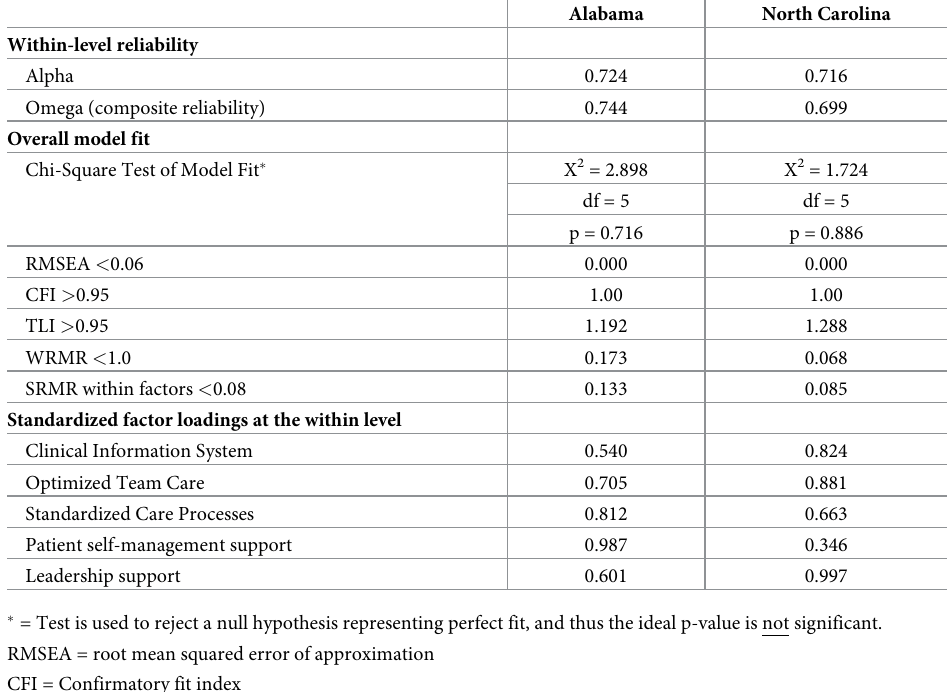
Table 5. Multilevel confirmatory factor analysis model comparisons by